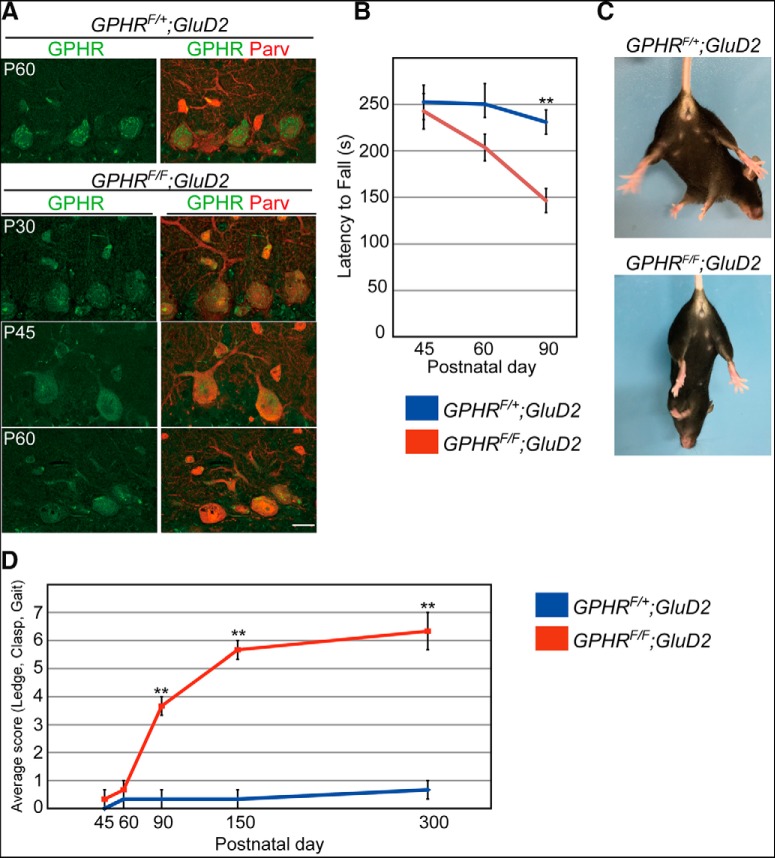
GPHRF/F;GluD2-Cre mice lack motor coordination. A, GPHR is deleted in PCs. Double immunofluorescence for GPHR (green) and parvalbumin (Parv; red) in the PC layer from GPHRF/+;GluD2-Cre mice at P60 and GPHRF/F;GluD2-Cre mice at P30, P45, and P60. Dotted immunoreactivity for GPHR is not discernable in PCs from GPHRF/F;GluD2-Cre mice after P45. Scale bars: 20 µm. B, Accelerating rotarod test for GPHRF/+;GluD2-Cre and GPHRF/F;GluD2-Cre mice. The average retention time on the rotarod is shown (n = 5 mice, female); **p < 0.001 (one-way ANOVA with Sidak’s post hoc test). C, Limb clasping reflex in GPHRF/F;GluD2-Cre mice at P90. When lifted by the tail, GPHRF/+;GluD2-Cre mice extended their hind limbs, whereas GPHRF/F;GluD2-Cre mice moved their legs to the trunk. D, Behavioral analyses of GPHRF/F;GluD2-Cre mice relative to GPHRF/+;GluD2-Cre mice. Graph showing cerebellar ataxic phenotypes score of GPHRF/+;GluD2-Cre and GPHRF/F;GluD2-Cre mice at P45, P60, P90, P150, and P300 (three mice per group). Average composite score for each genotype at each age was calculated. Data are presented as the mean ± SEM; n = 9 trial for each group, **p < 0.01 (Kruskal–Wallis test followed by the Dunn’s test). For A, three mice per genotype; n = 5 sections per mouse; representative images are shown. See also Movie 1.